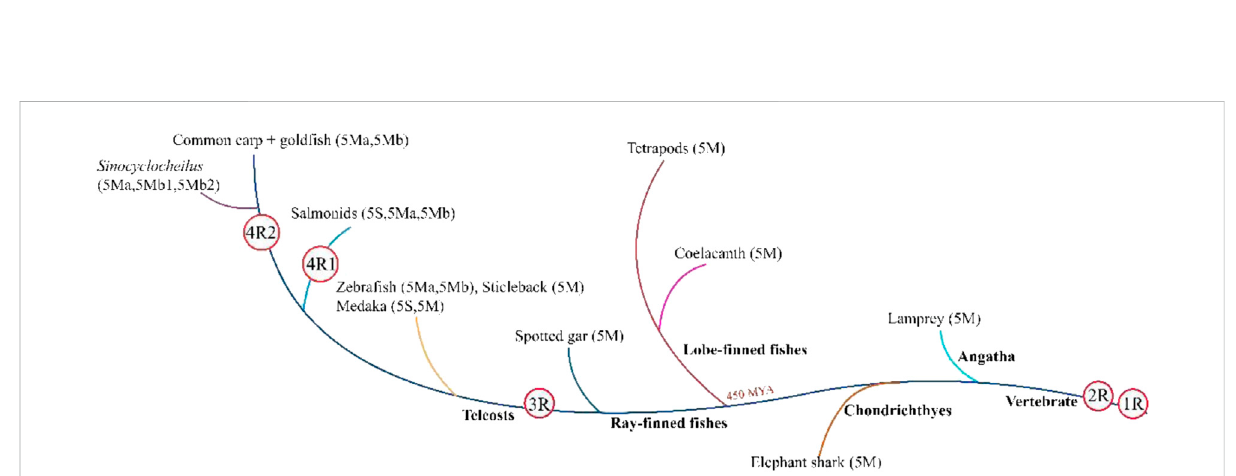
FIGURE 5 All teleost fi shes undergone at least three whole-genome duplication (WGD) events, the two earlier rounds of vertebrate genome duplication (1R and 2R) that occurred before the di-vergence of lamprey and hag fi sh from the jawed vertebrates, and the third teleost-speci fi c WGD (3R) at the baseoftheteleosts320millionyearsago(MYA).Atlanticsalmonandrivertroutsharethesalmonid-speci fi cWGD(4R1)thatoccurredinthecommon ancestor of salmonids 80 MYA. Common carp and gold fi sh share the fourth WGD (4R) that occurred approximately 14 MYA in their common ancestor. Atlantic salmon and river trout share the salmonid-speci fi c WGD (4R 1) that occurred in the common ancestor of salmonids 80 MYA. Common and gold fi sh share the fourth WGD (4R 2) that occurred approximately 14 MYA in their common ancestor. The TLR5 isoform is given in